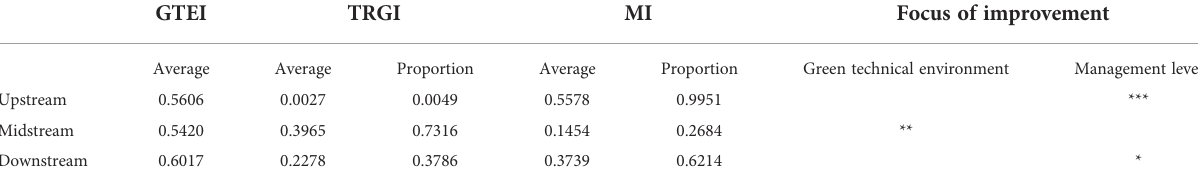
TABLE 7 Decomposition of GTEI values for each link of the industry chain after adjustment. GTEI TRGI MI Focus of improvement